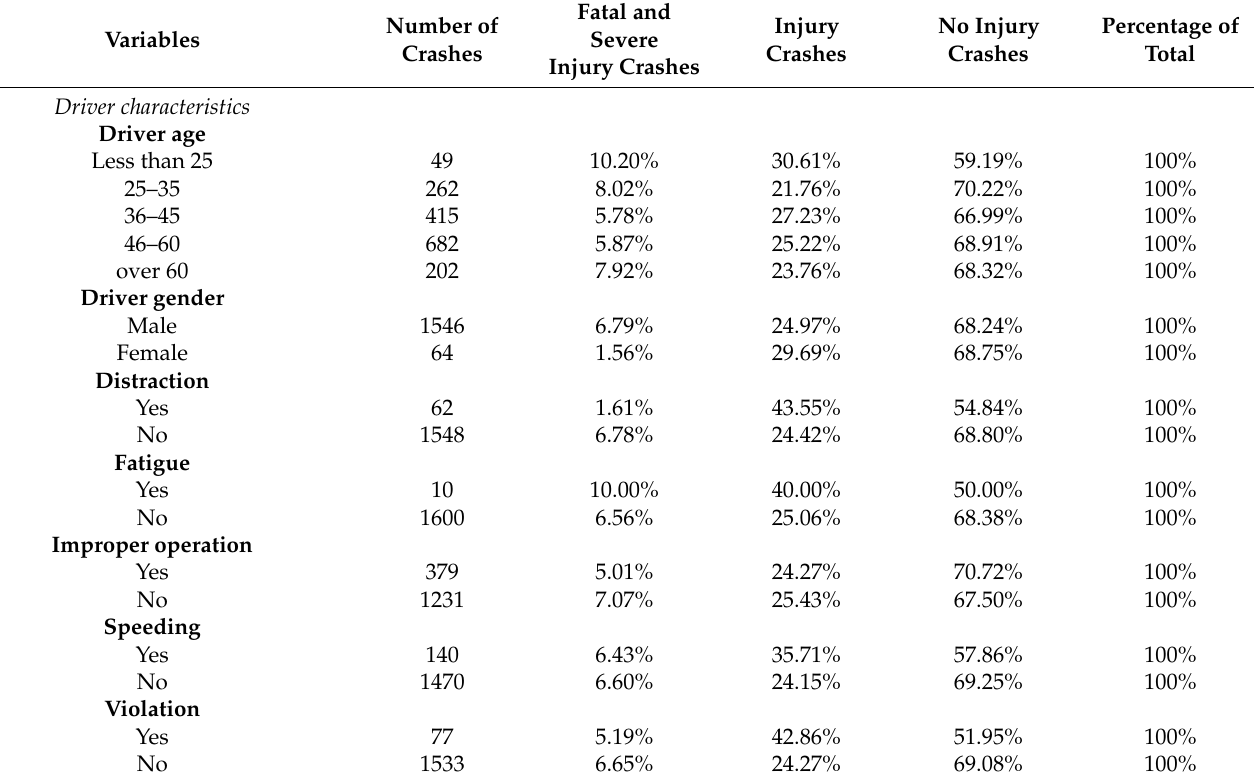
Table 1. Characteristics of HAZMAT road transportation crashes by